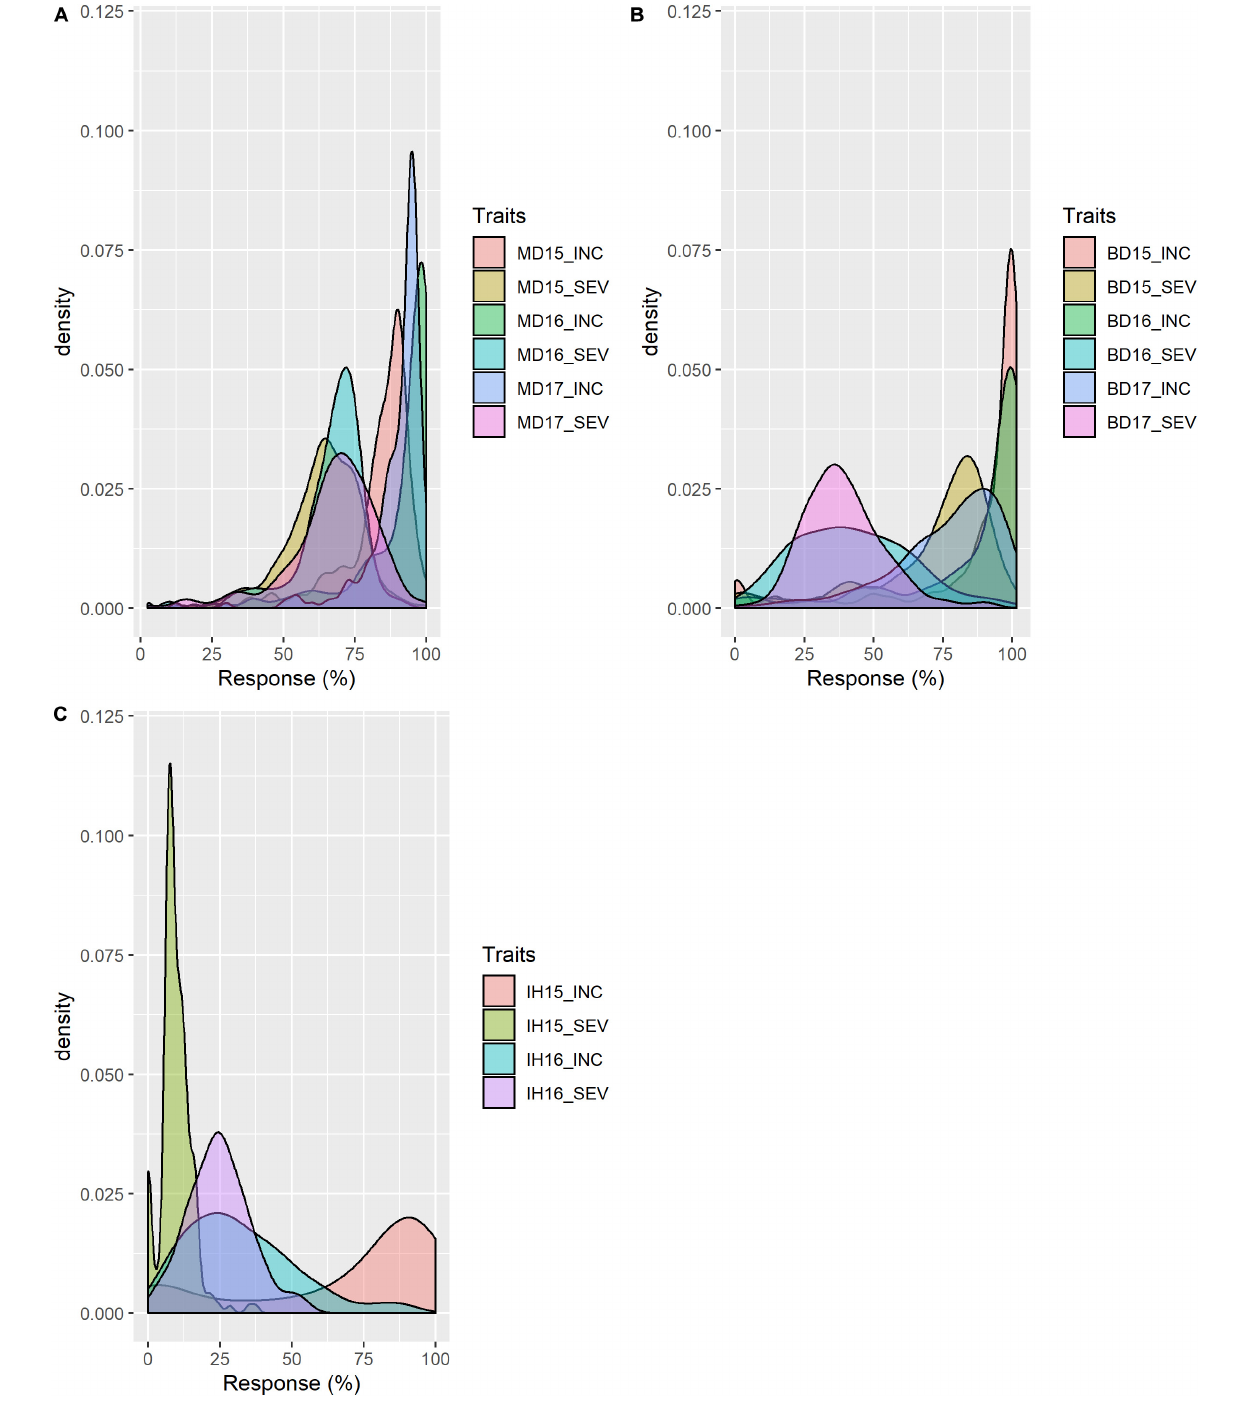
in the region between 585 and 591 Mb of 5A had a relatively stable effect for INC in both Brandon, MB, and Indian Head, SK ( Figures 4 , 5 and Table 2 ). It was detected at a low level for HT